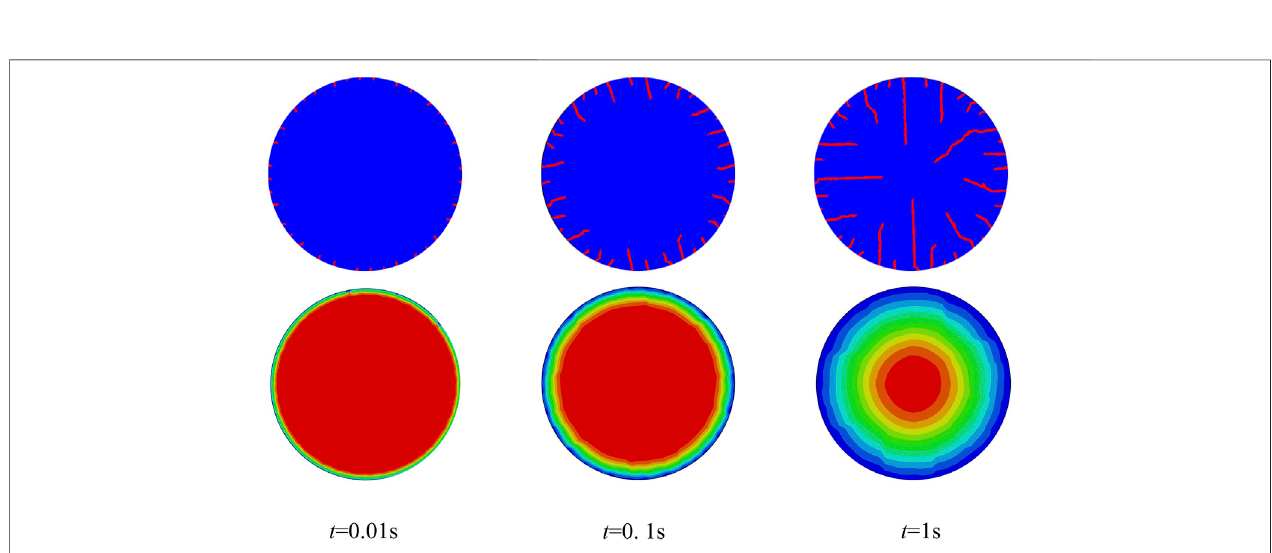
FIGURE 5 | Thermal shock-induced crack evolution and its corresponding temperature fi eld of circular Al 2 O 3 under the initial temperature of 500 ° C.